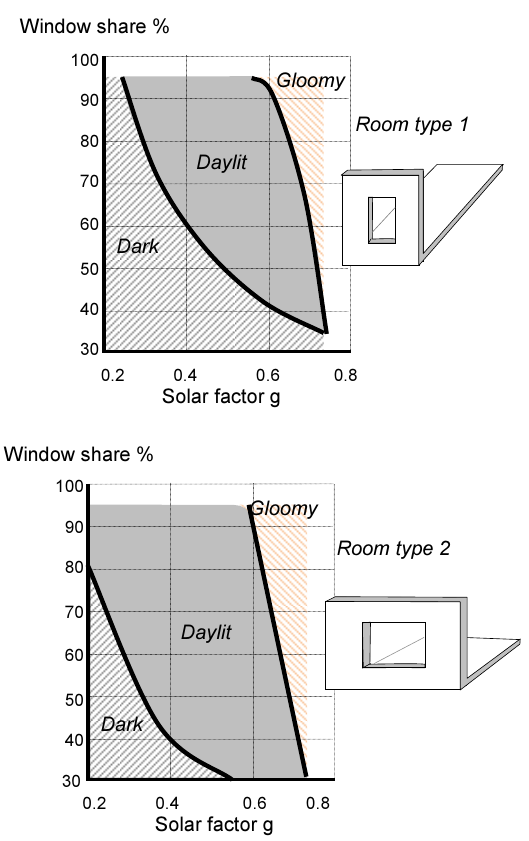
Fig. 3. Possible window glass share and solar factor combina- tions that fulfil the requirements: The daylight factor should be 2 or above and the difference between the lowest and highest daylight factors must not exceed 20. The result is valid for all